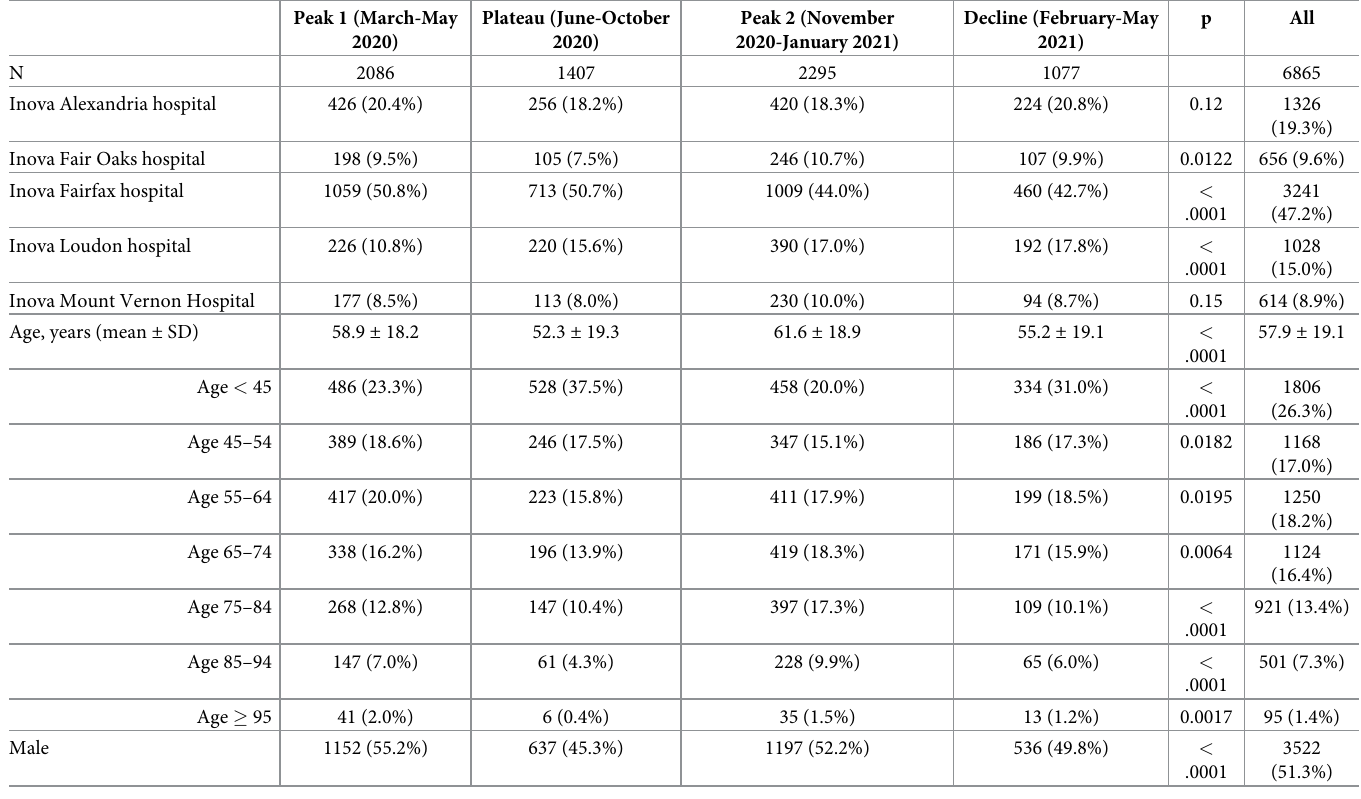
Table 1. Clinical and demographic characteristics of patients admitted to hospitals of Inova Health System by the period of